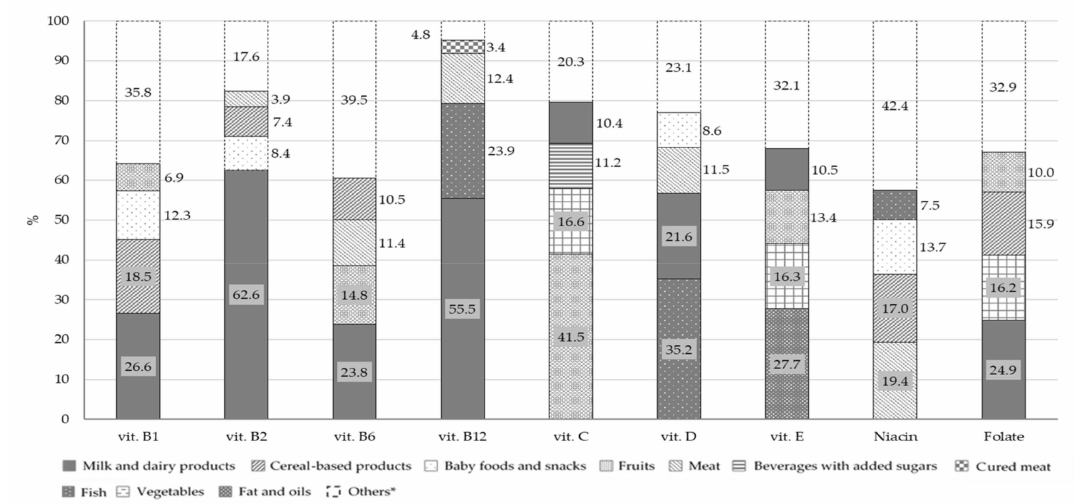
Figure 6. Percentage contribution of selected food groups to total intake of vitamins ( n = 389). * For each variable, the category “Others” includes all the food groups not considered independently.